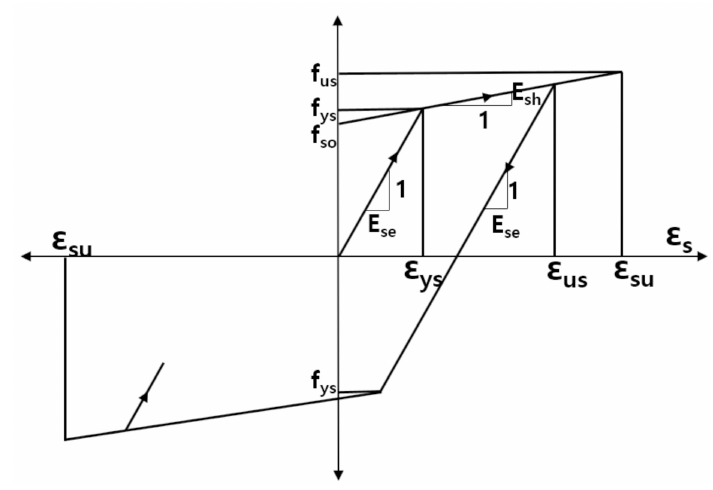
Figure 5. Stress–strain curve for steel reinforcement.